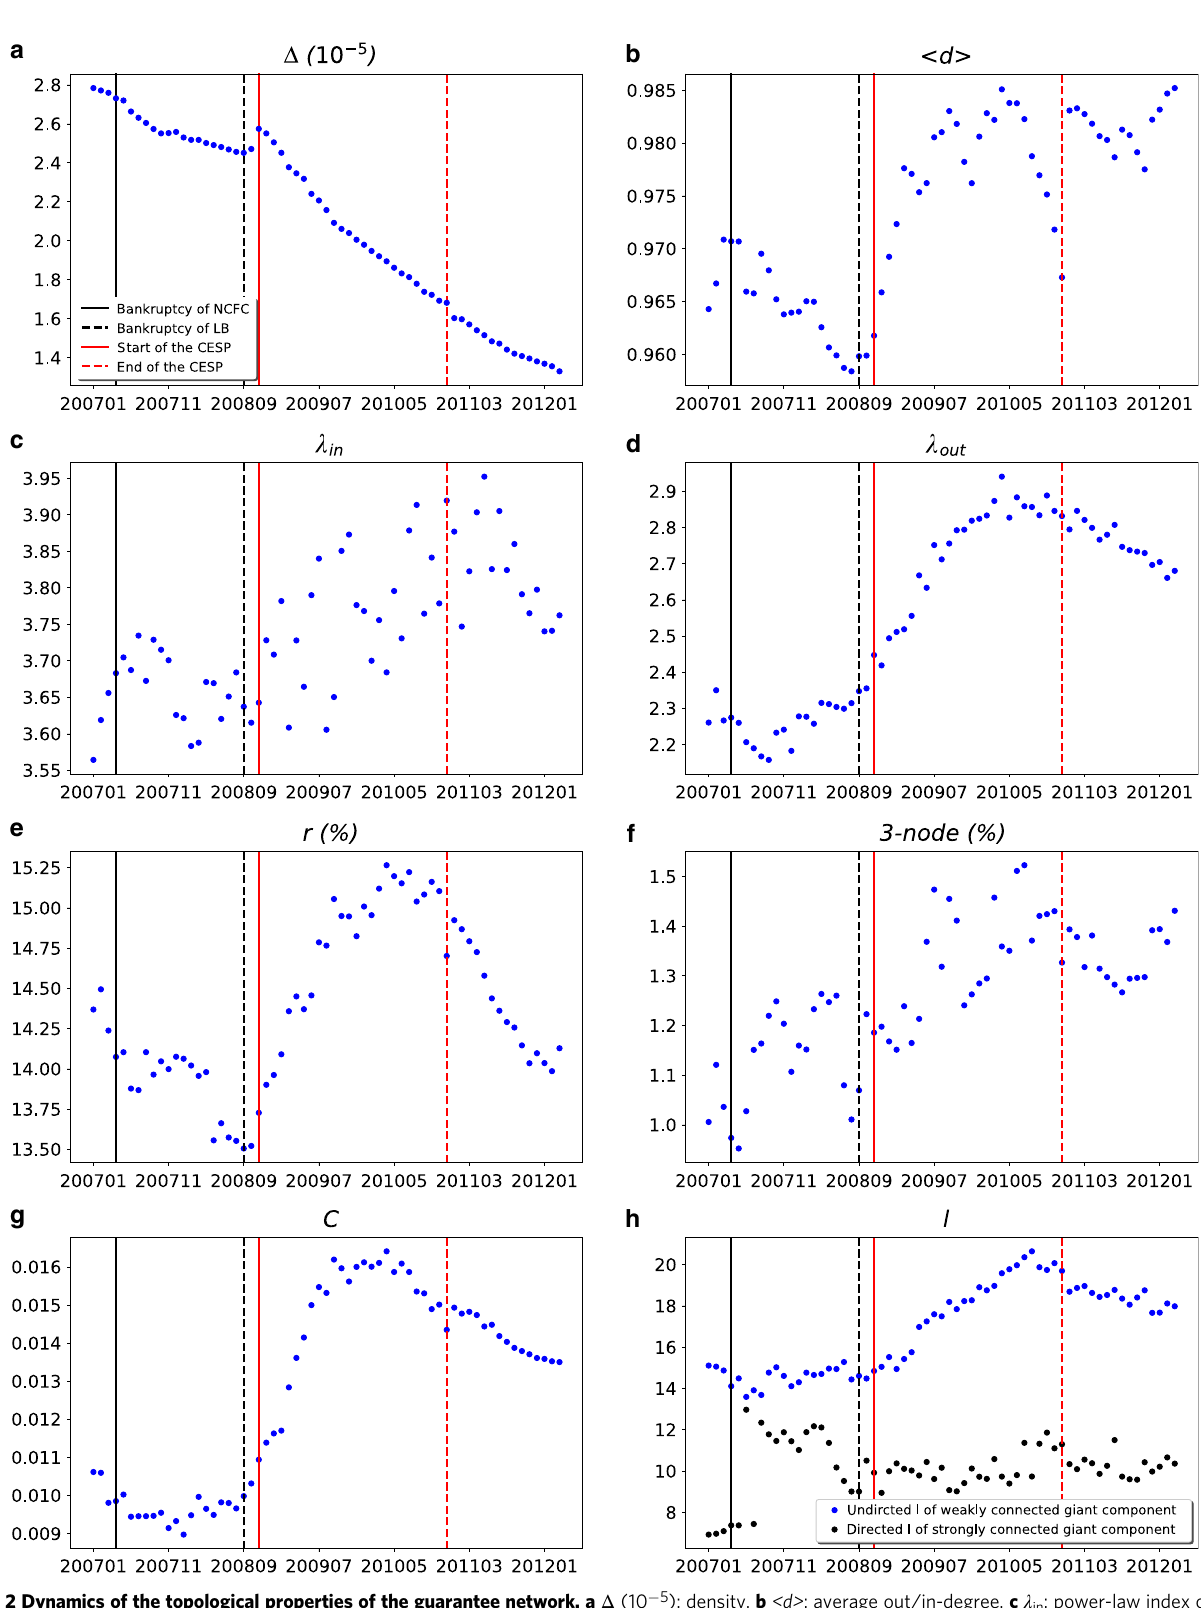
Fig. 2 Dynamics of the topological properties of the guarantee network. a Δ (10 − 5 ): density. b <d> : average out/in-degree. c λ in : power-law index of in- degree distribution. d λ out : power-law index of out-degree distribution. e r (%): reciprocity. f 3 – node (%): ratio of fully connected three nodes. g C : average clustering coef fi cient (directed). h l : average shortest path length in the weakly connected giant component and strongly connected giant component. Source data are provided as a Source Data fi